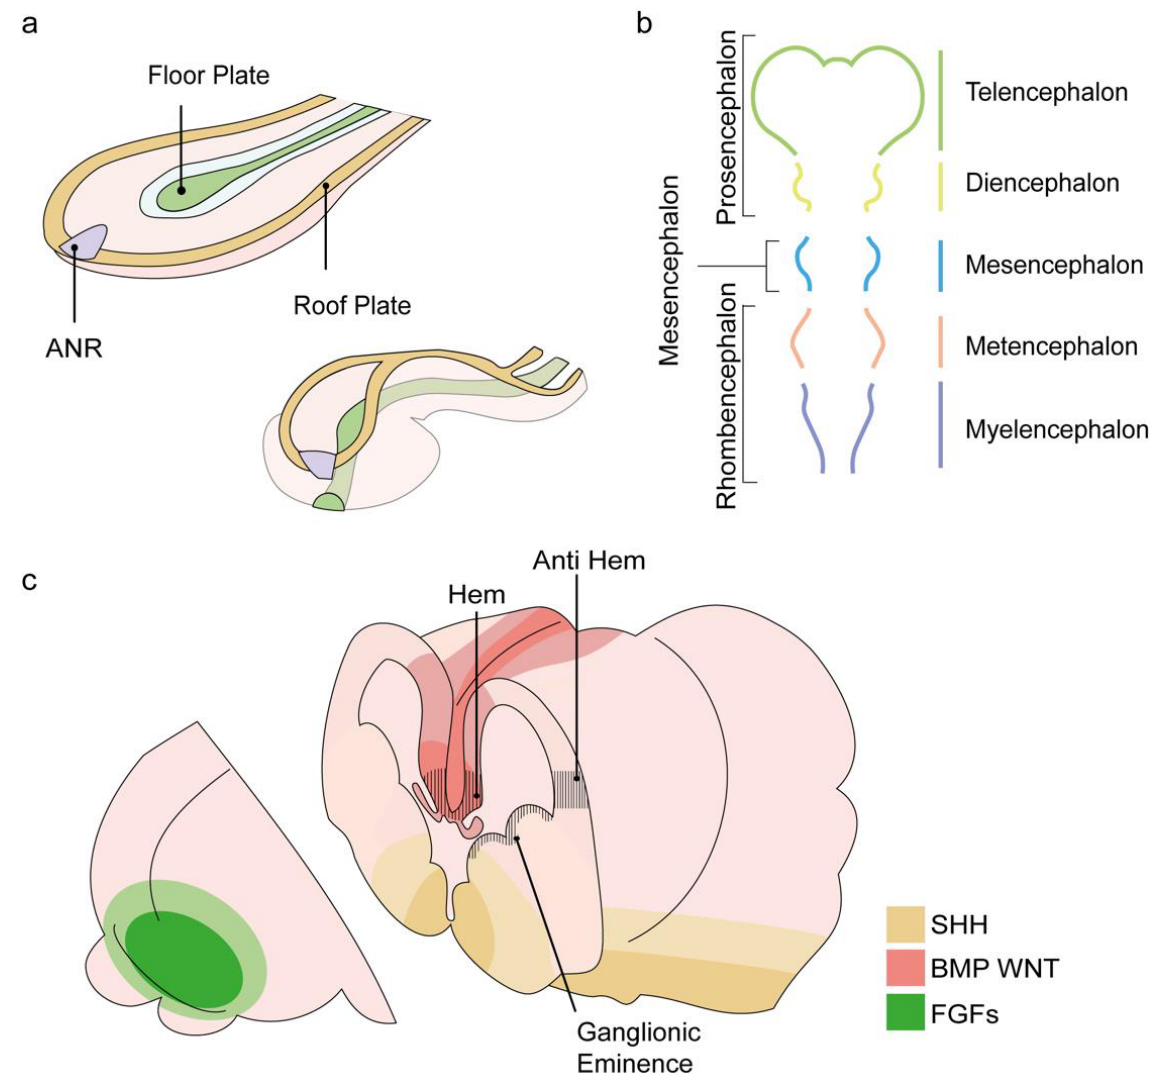
Figure 1. Schematic presentation of the events leading to forebrain formation. ( a ) Rostro-lateral representation of the neural plate as it folds and fuses at the midline to form the neural tube. The anterior neural ridge (ANR), shown in purple, is an organizer of the forebrain. Positioned at the most rostral part of the neural plate, its signaling will promote the formation of the future forebrain structure, the prosencephalon. Modified from [6]. ( b ) The primary vesicles appear in the fourth week of development and introduce three morphological segments of the brain: the prosencephalon, the mesencephalon, and the rhombencephalon. By the following week, the prosencephalon will further subdivide into the future forebrain structures: the anterior neural tube, the two telencephalon vesicles, and the diencephalon. ( c ) Sources of key morphogens are indicated; FGFs in green, BMPs and WNTs in red, SHH in yellow. The positions of the hem, anti-hem, and ganglionic eminences are indicated with black lines. Modified from [7].